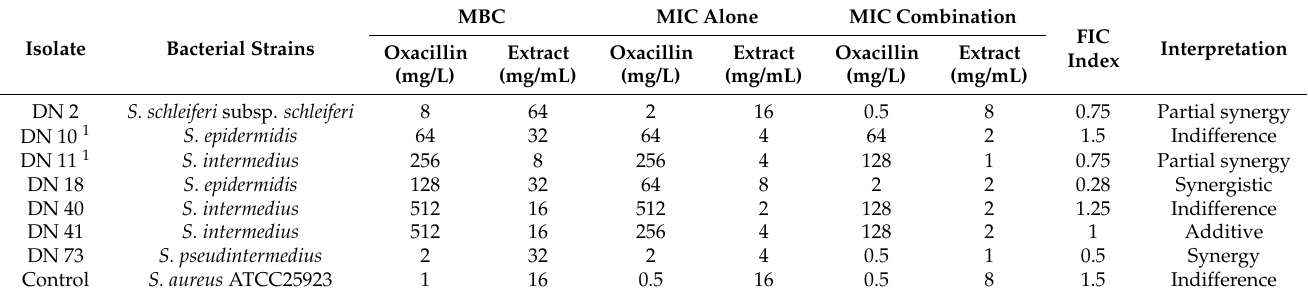
Table 3. Synergistic activity of the S. torvum leaf extract with oxacillin against methicillin-resistant